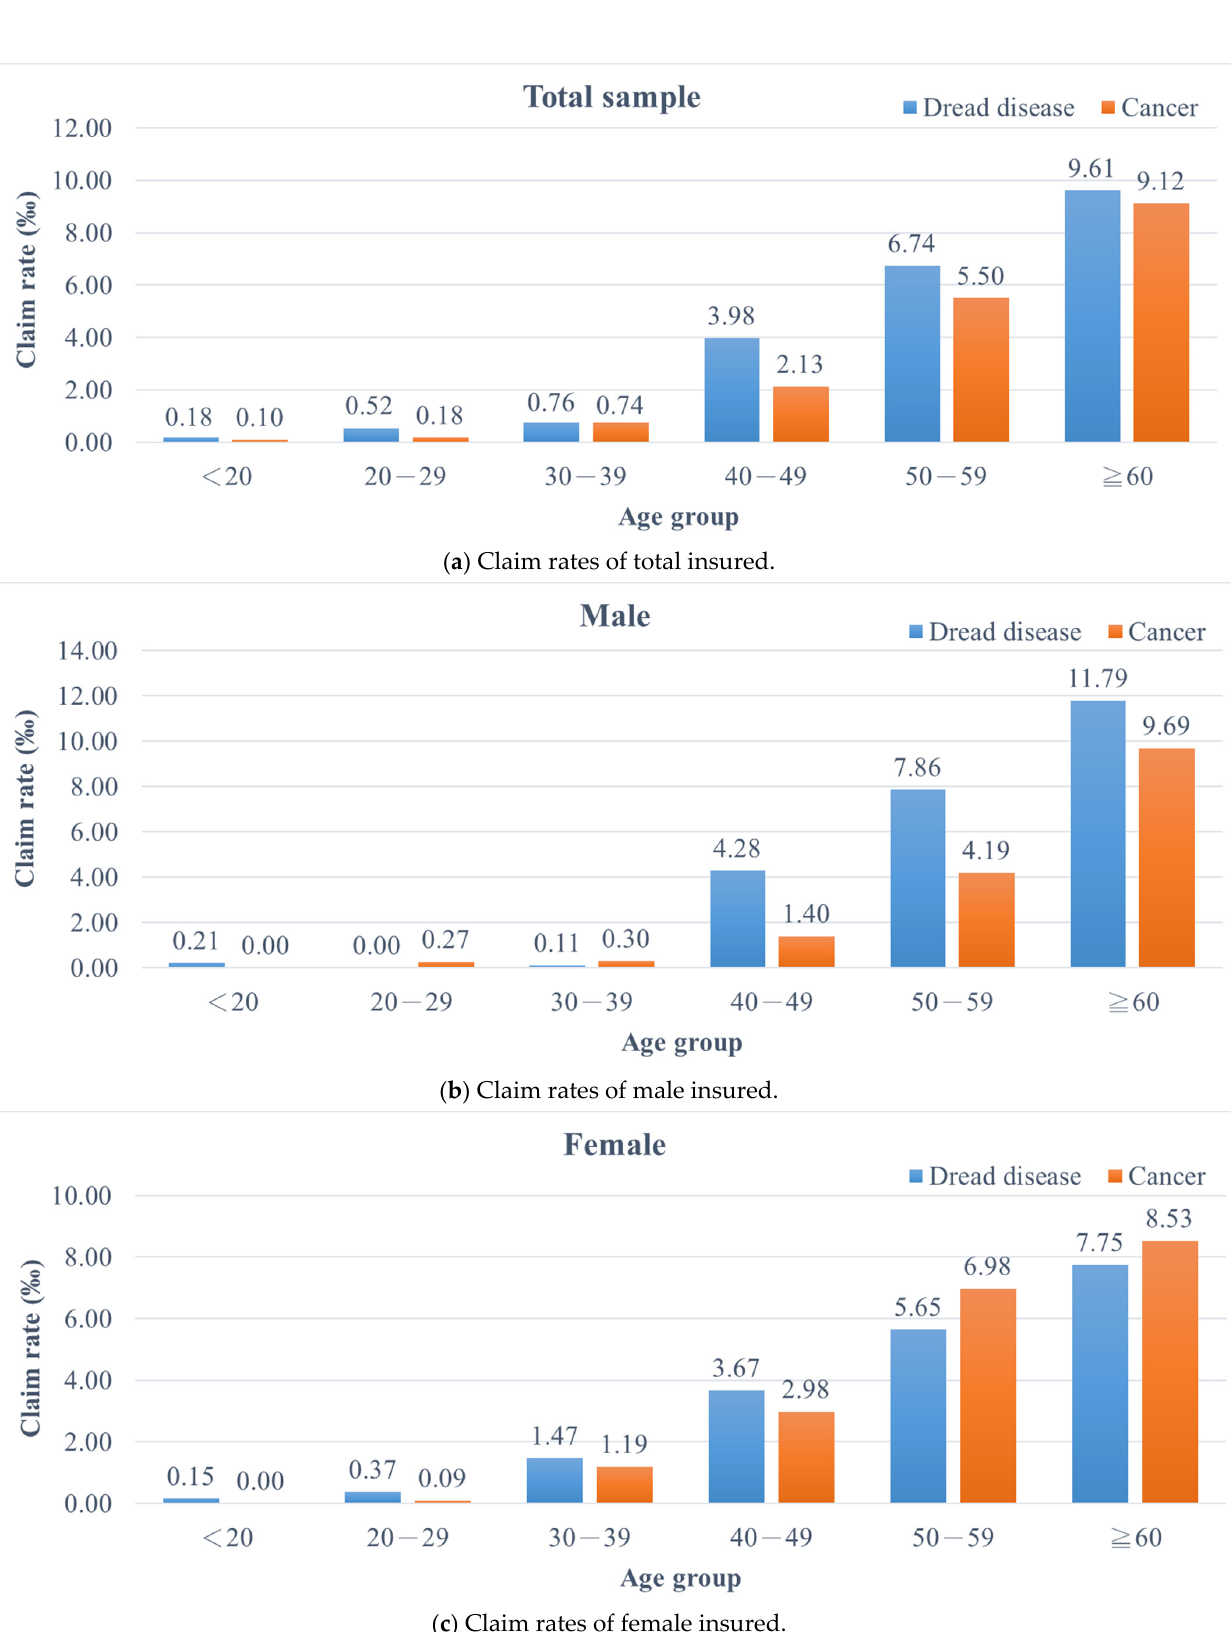
Figure 1. Claim rates of different age groups for dread disease and cancer insurance policies by gender (Claim rate = # of claims for each age group/# of insurance policies for each age group). ( a ) Claim rates of total insureds; ( b ) claim rates of male insureds; ( c ) claim rates of female insureds.